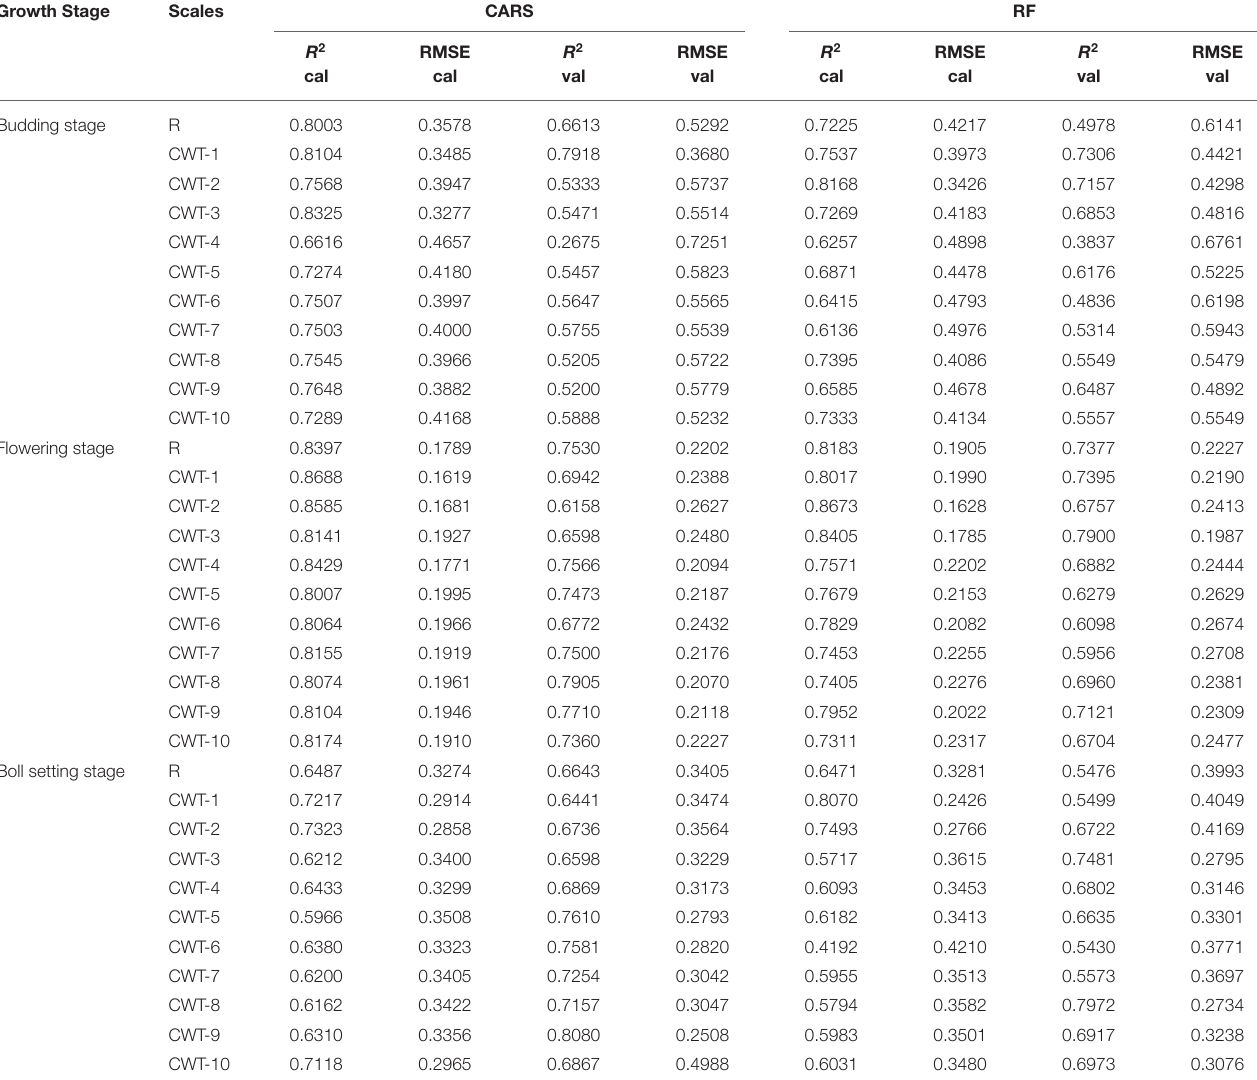
TABLE 3 | CARS and RF algorithms are used to screen the characteristic wavelengths of the wavelet coefficient spectra, the PLSR estimation model of cotton LKC in different growth stages is established, and emphasize the relatively better performances of these the wavelet coefficient spectra in LKC estimation. Growth